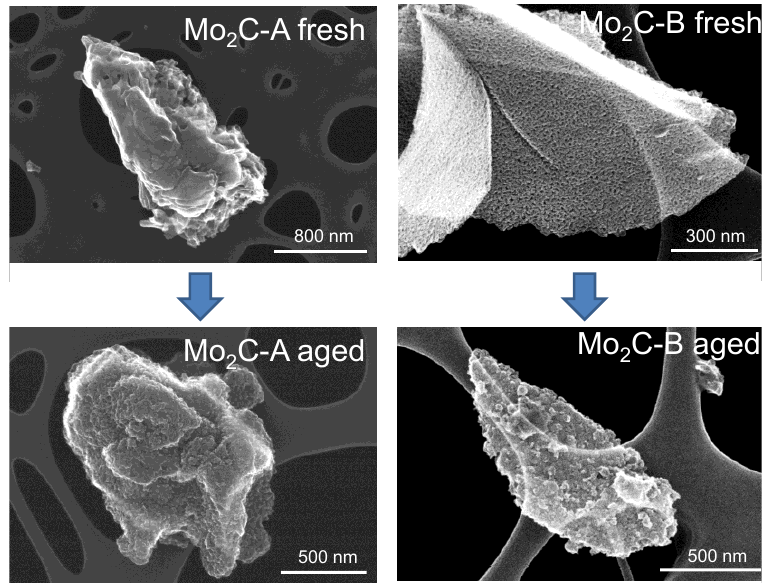
Figure 3. SEM images of two Mo 2 C samples in the fresh state and after 48 h aging at 250 °C in liquid water; smaller particles taken at high